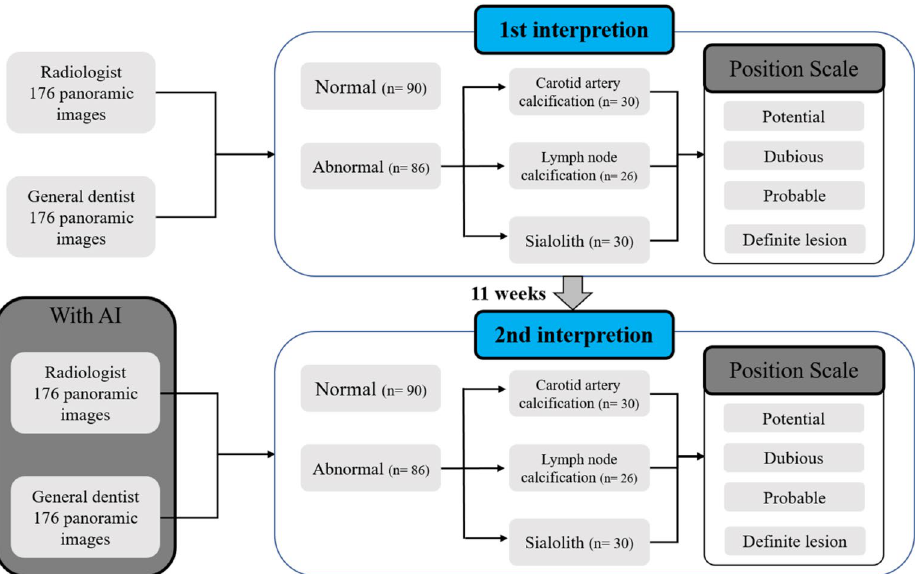
Figure 2. Schematic of observer study design. The first readings were 176 images without artificial intelligence. Abnormal images are separated first and classified as carotid artery calcification, lymph node calcification, or sialolith. Reading confidence is then expressed on a 1 through 4 confidence scale. The second reading takes place 11 weeks after the first reading, and 176 images, different from the first reading, are read using the AI algorithm. Normal and abnormal images are classified first and then a confidence scale of 1 through 4 is